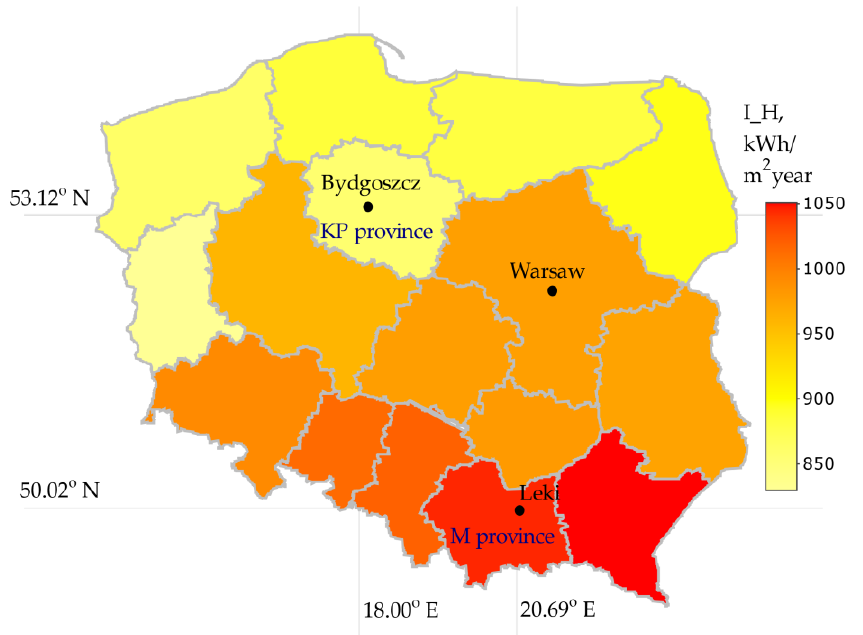
Figure 1. Yearly horizontal insolation in Poland calculated per province’s capital city. KP province—Kuyavian-Pomeranian; M province–Lesser Poland. Source own study based on [18].